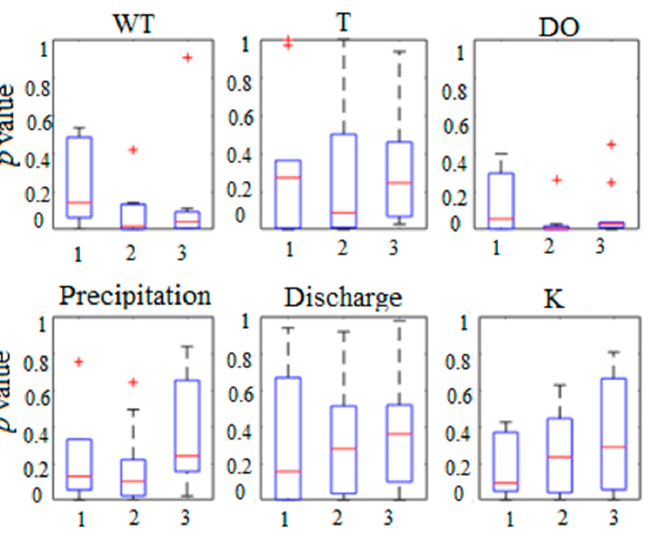
Figure 9. Same as in Figure 7, but for Tu as an effect in the Granger causality relationship.